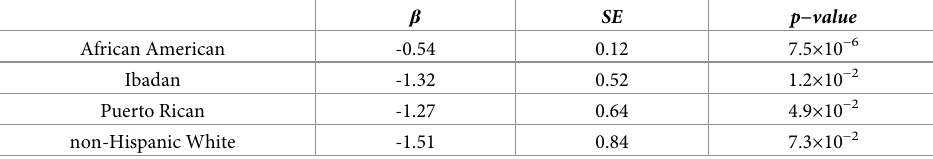
Table 1. Effects of the rs10423769 genotype and its ApoE ε 4 allele interaction terms in the logistic regression model across studies.